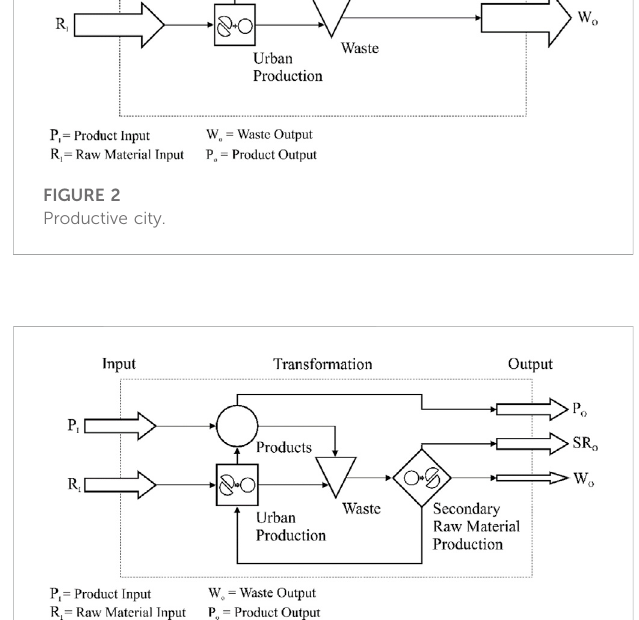
FIGURE 3 Symbiotic productive